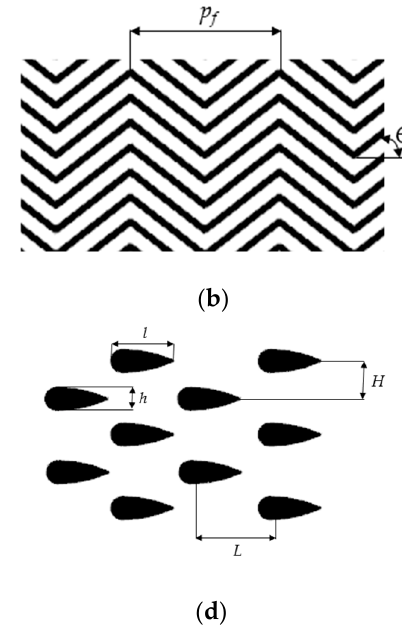
Figure 4. Considered configurations of heat exchanging surfaces. Table 2. Channels geometry parameters.